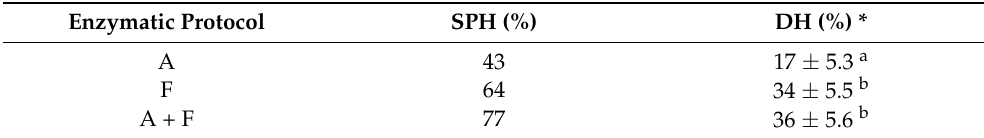
* Values are reported as mean ± error% of three independent replicates. Different superscript lowercase letters represent values with a discrepancy greater than the calculated